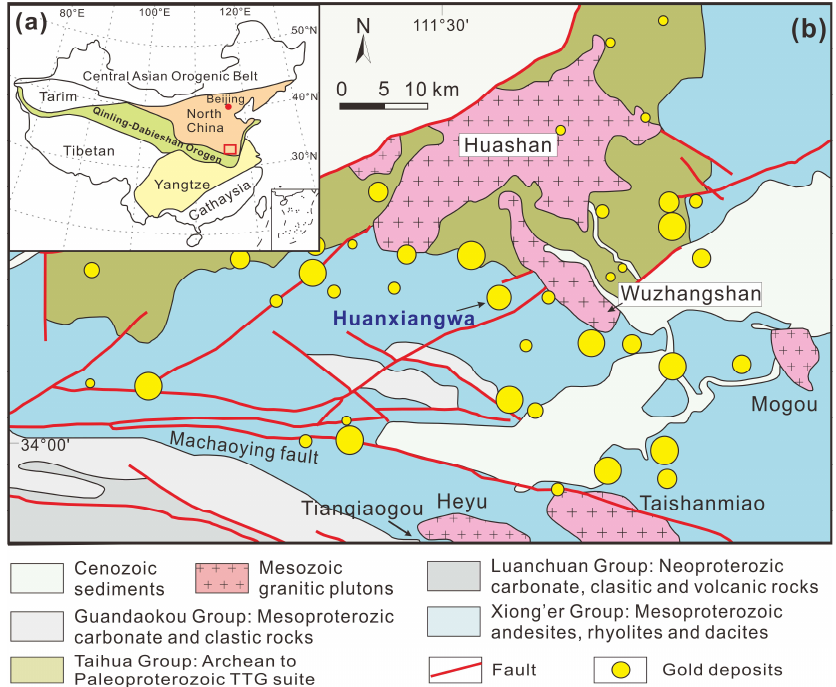
Figure 1. ( a ) Simplified structural map of China showing the major tectonic subdivisions and the location of the Xiong’ershan gold district [12,13]. ( b ) Simplified geological map showing the distribution of gold deposits in the Xiong’ershan area [12].